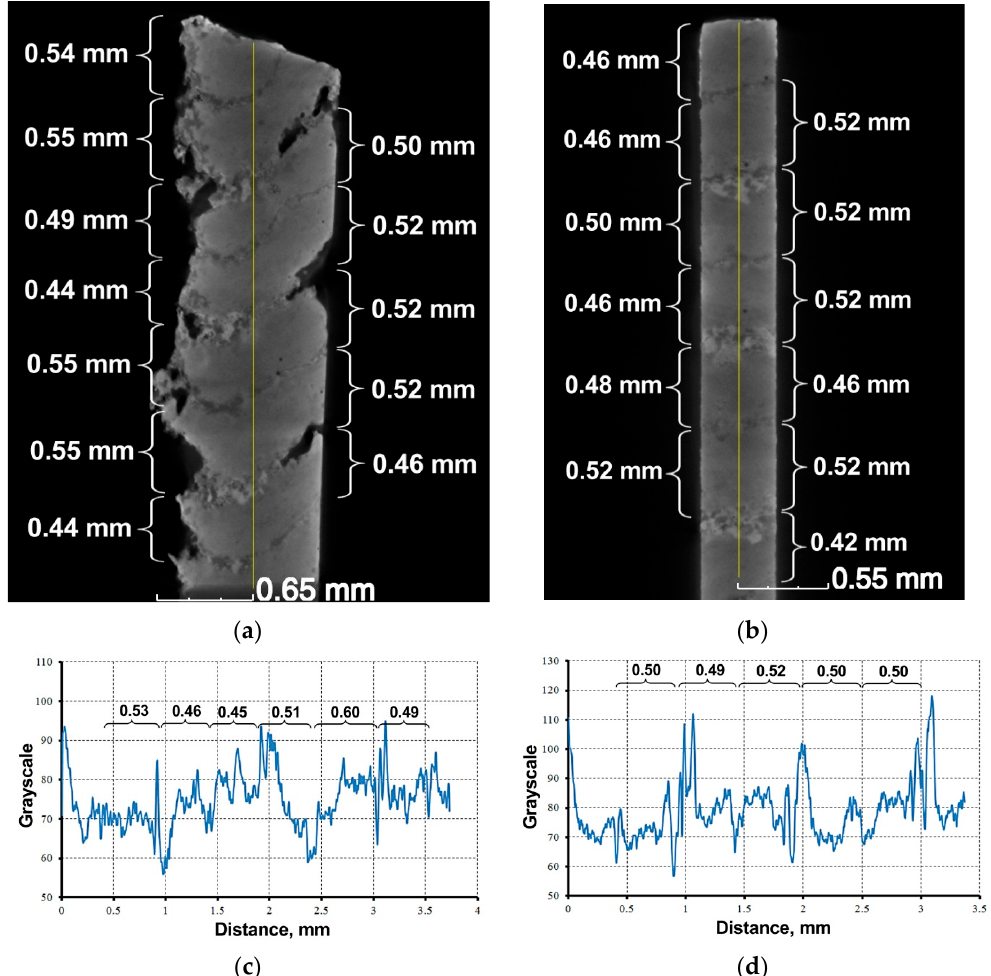
Figure 7. Frontal ( a ) and profile ( b ) projections of the TiNi–TiB 2 metal–matrix composite obtained by direct laser deposition, and the corresponding graphical representation of the change in gray values along the vertical line of the section ( c , d ).